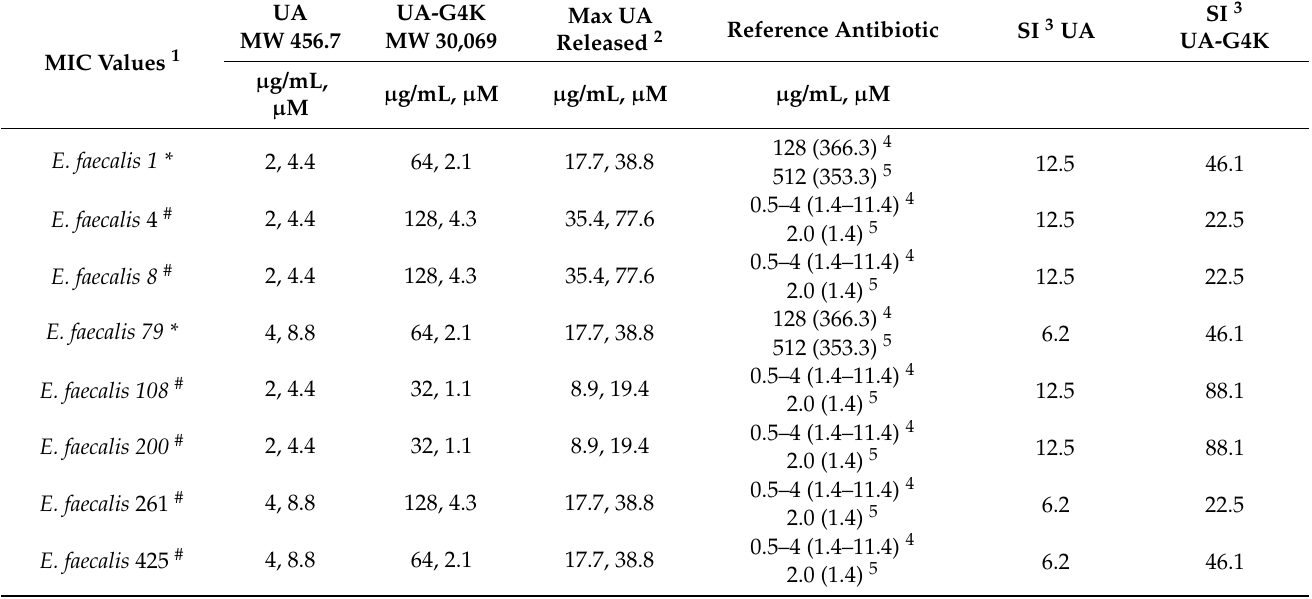
Table 3. MICs of UA and of UA-G4K, expressed as µ g/mL and micromolarity ( µ M), against the enterococci tested in the study, and the maximum concentrations of UA released according to the MICs observed for the UA-loaded dendrimer NPs and based on its DL% and release profile [47]. The last two columns contain the values of selectivity indices (SI) of UA and UA-G4K NPs,